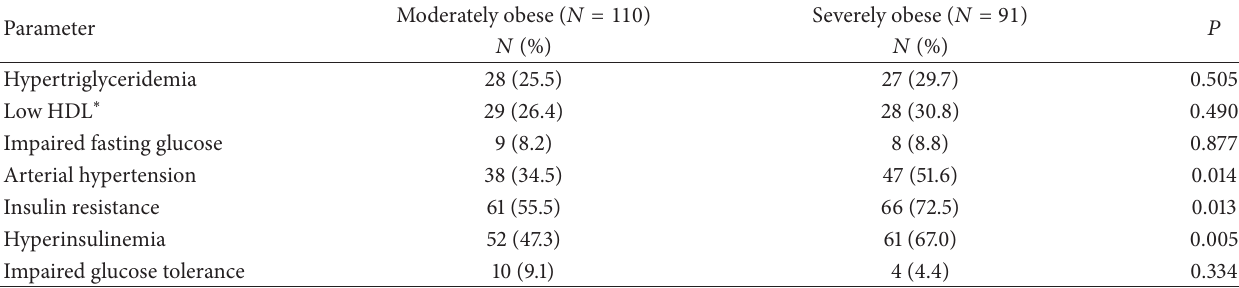
Table 3: Prevalence of individual risk factors in moderately and severely obese subjects.